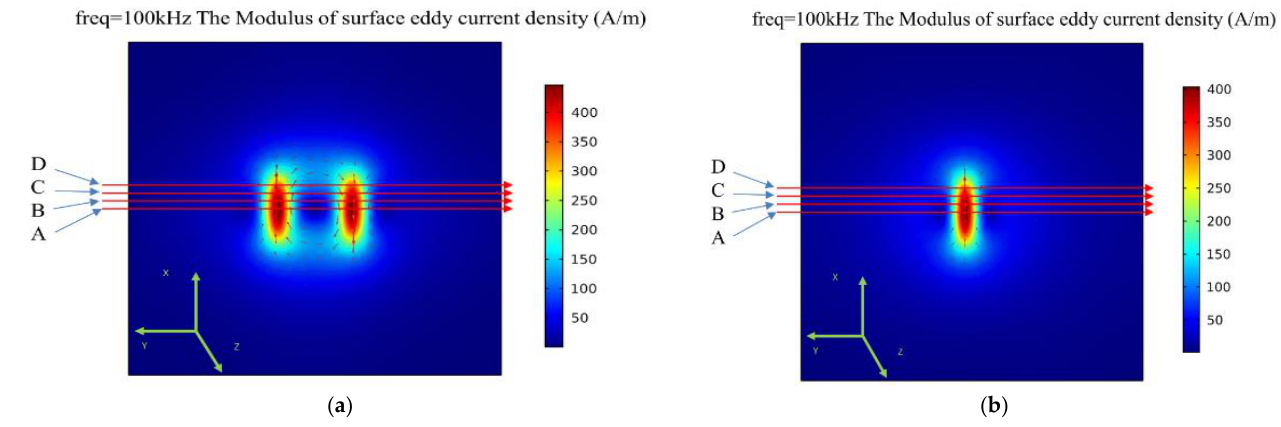
Figure 4. The eddy current fields of UEC probes: ( a ) dual-excitation UEC probe; ( b ) traditional UEC probe.